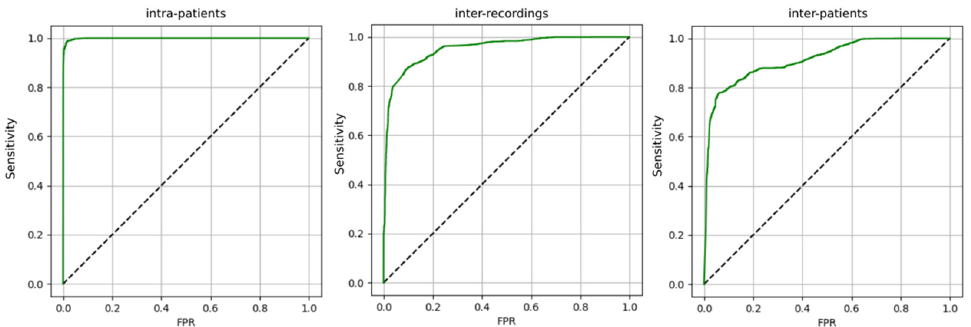
Figure 3. ROC curves for detection of the effectively stimulated heartbeats in CRT therapy, including different scenarios of model training.